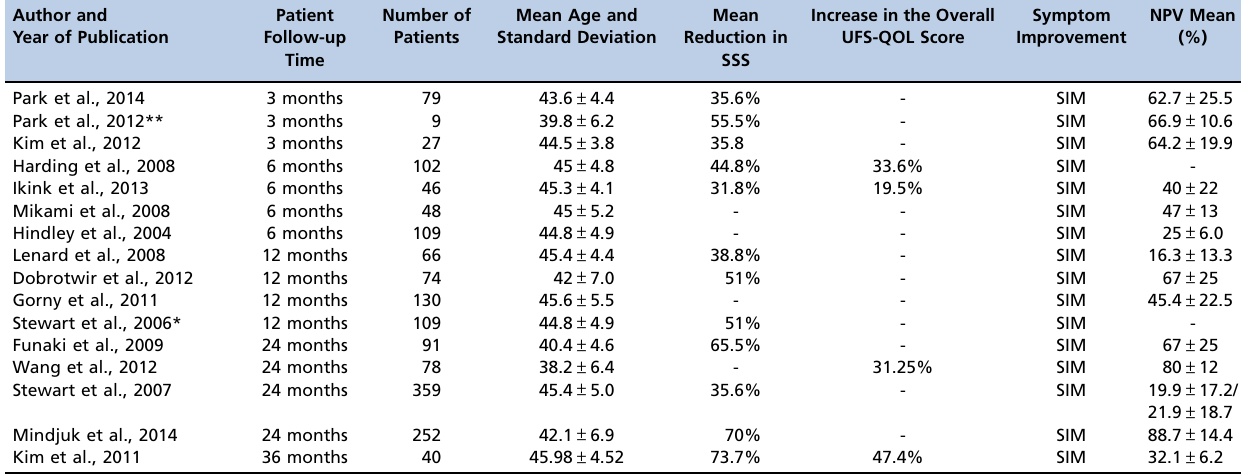
SSS: Symptom Severity Score. *Clinical Trial. **Study of women with pedunculated subserosal fibroids.